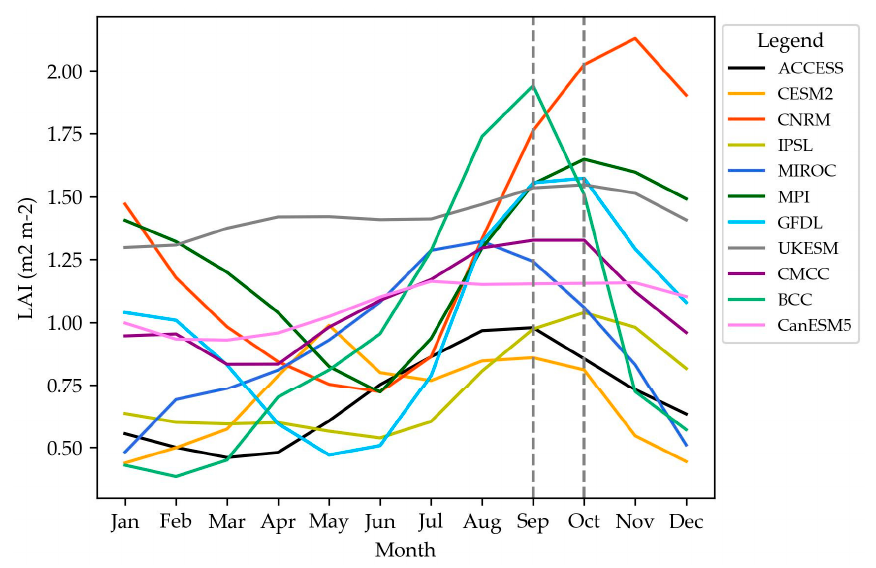
Figure 5. LAI climatologies from 1950 to 2014 in South Asia. The dotted gray lines indicate the two months when LAI peaks for most models.